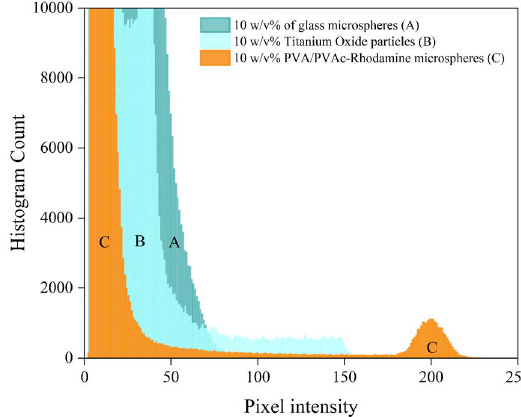
Figure 9. Histogram count vs Pixel Intensity obtained from photographs of non-fluorescent particles and PVA/PVAc-Rhodamine microspheres